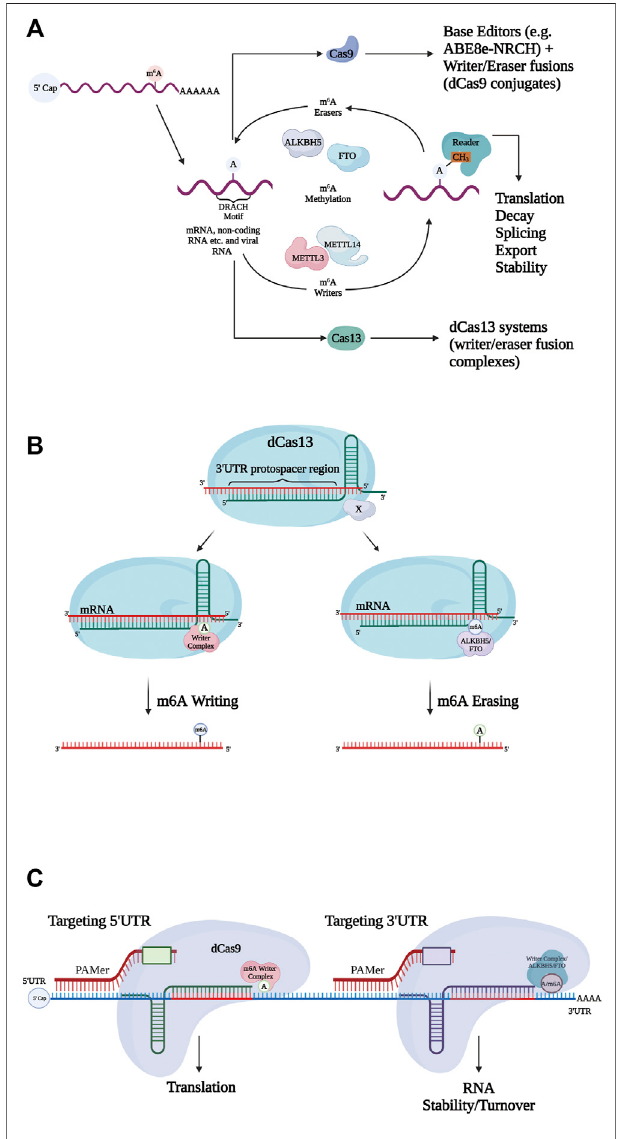
FIGURE 2 | Mechanisms for N6-methyladenosine (m6A) regulation. (A) Writers and erasers tightly regulate the presence of m6A on transcripts, by targeting the m6A motif (DRACH). m6A is recognized by readers, initiating steps regulating mRNA stability, translation etc. Modi fi cation systems can be expanded to include both Cas9 (base editors, writer/eraser fusions) and Cas13 ((de)methylation systems). (B) Catalytically inactive Cas13 (dCas13) fused to writer and eraser domains install and remove m6A modi fi cations respectively. Single guide RNAs (sgRNAs) target speci fi c sites (e.g., 3 ′ UTR protospacer) for mRNA binding. (c) Catalytically inactive Cas9 (dCas9) conjugates fused to writer and eraser domains. Speci fi c sgRNAs allow individual 5 ′ UTR and 3 ′ UTR targeting. Resulting effects of installing/ erasing at the different UTRs vary. PAMer provides the NGG PAM sequence.